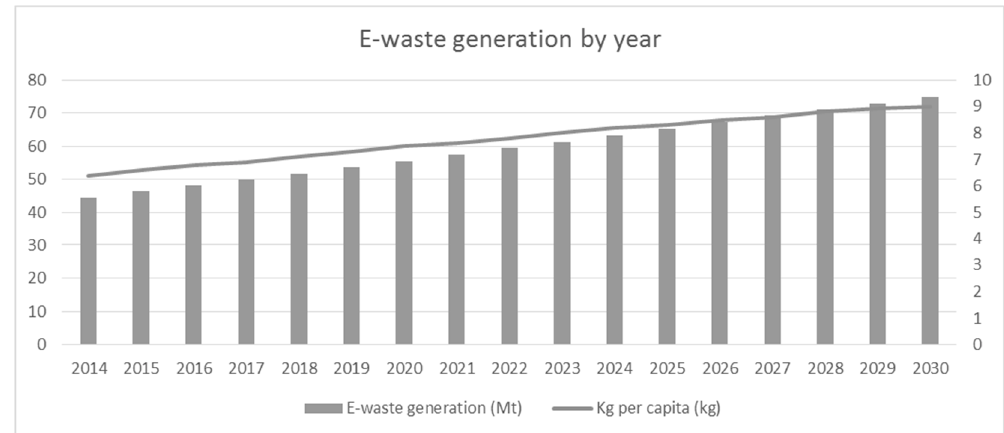
Figure 1. Trend of global Waste Electrical and Electronic Equipment production, overall and per capita (adaptation by the authors of the data from [11]).